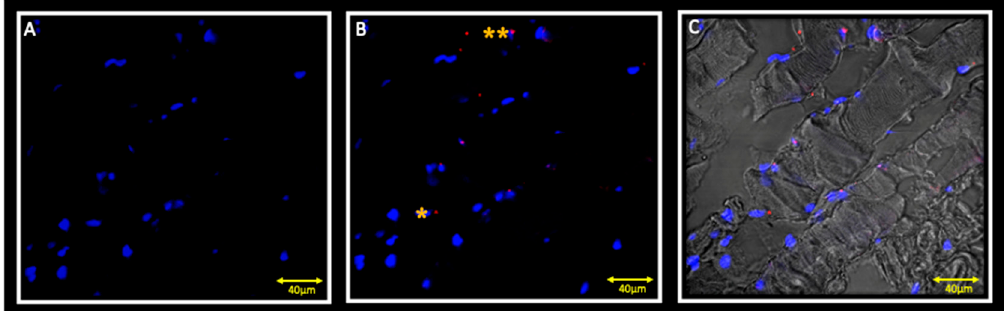
Figure 4. Immunofluorescence reaction in double localization performed on ipsilateral masseter muscle. Results show no Myf5 positive cells ( A ) and a small number of PAX7 (red channel) positive cells ( B ); double yellow asterisks indicate PAX7 positive cells. Figure ( C ) shows the transmitted light.